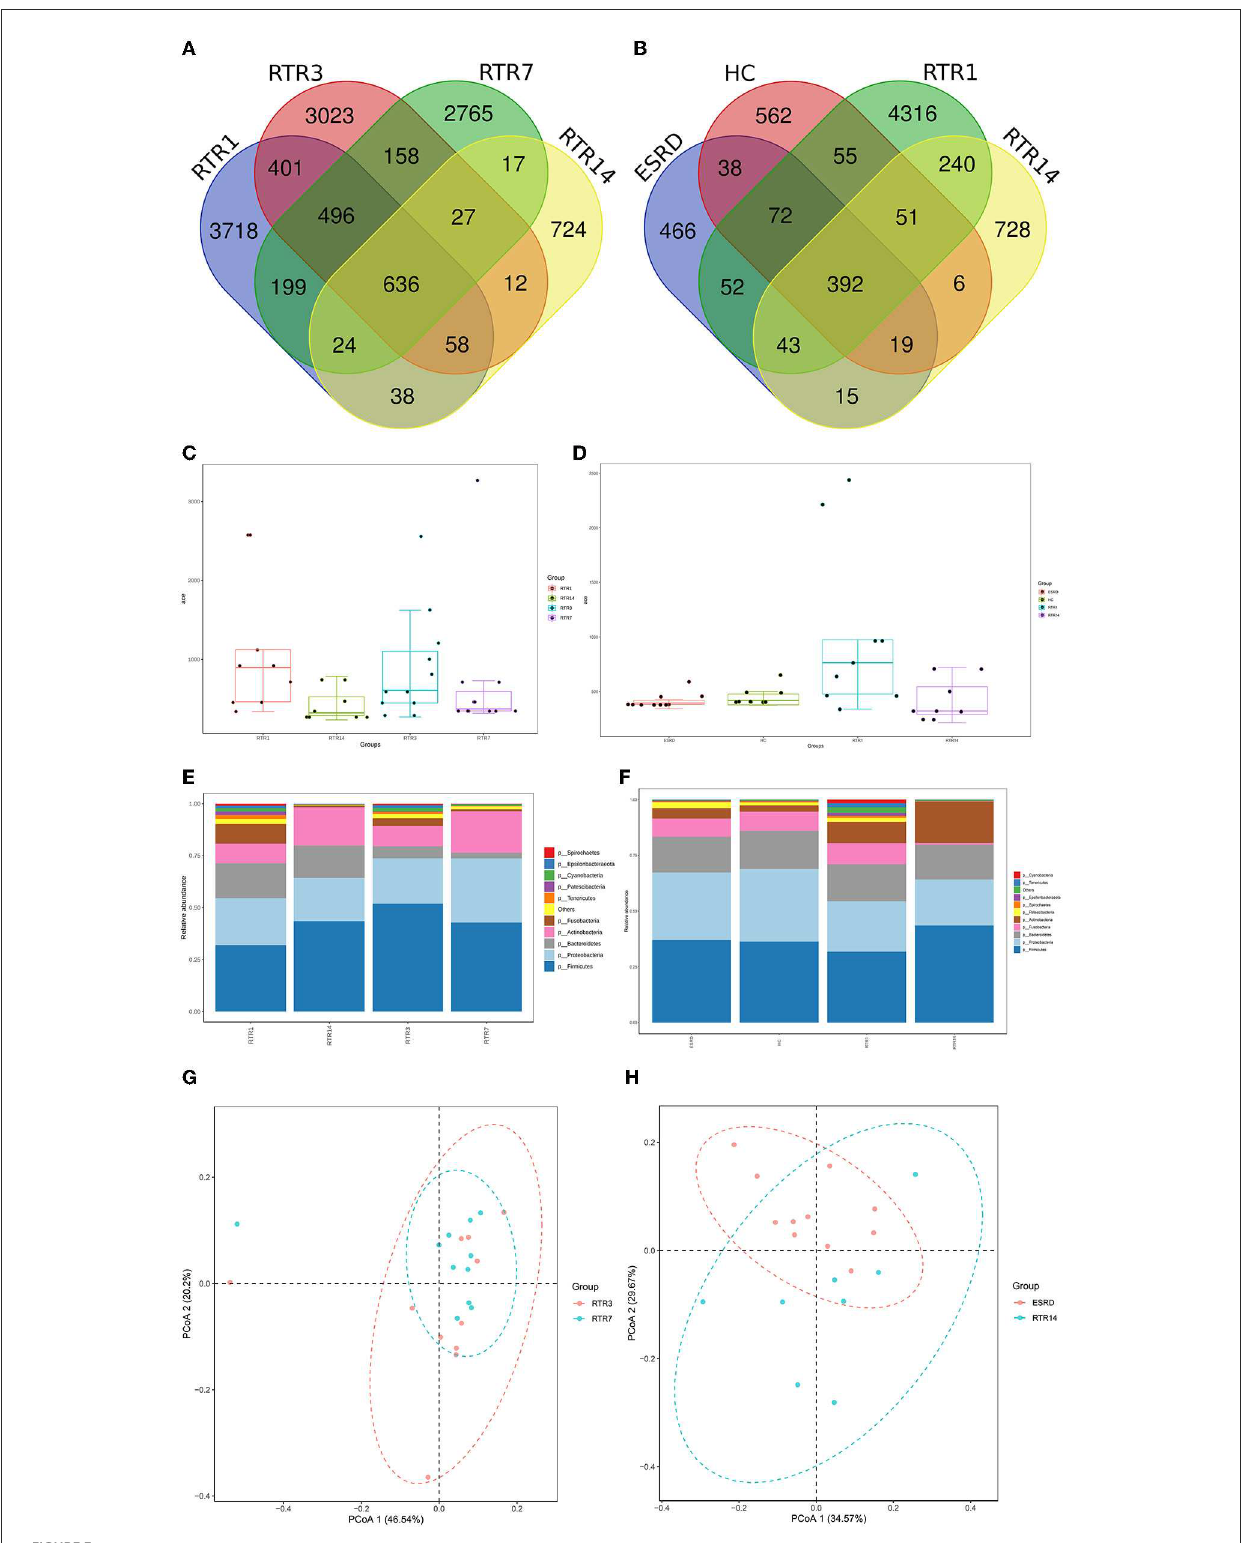
FIGURE3 Composition characteristics of salivary microbiota at different time points and states: (A) the Venn graph for OTUs of the RTR group at different time points; (B) the Venn graph for OTUs of the RTR1, RTR14, ESRD, and HC; (C) the Ace index of the RTR group at different time points; (D) the Ace index of the RTR1, RTR14, ESRD, and HC; (E) salivary species composition of RTR group at different time points at the phylum level; (F) salivary species composition of RTR1, RTR14, ESRD, and HC at the phylum level; (G) PCoA graph of RTR3 and RTR7; (H) PCoA graph of RTR14 and